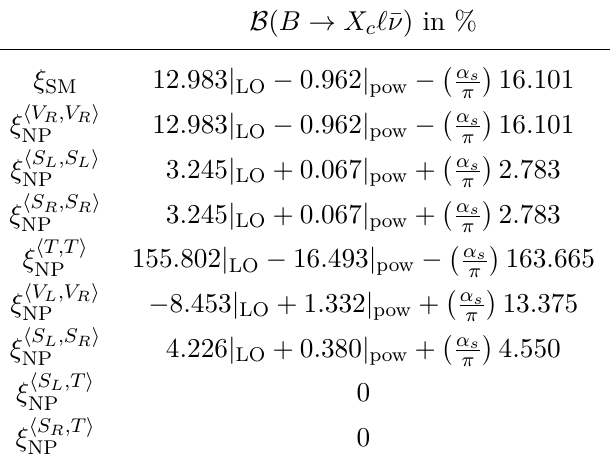
Table 3. Numerical values of the parameters for the branching ratio without lepton energy cut for fixed B meson